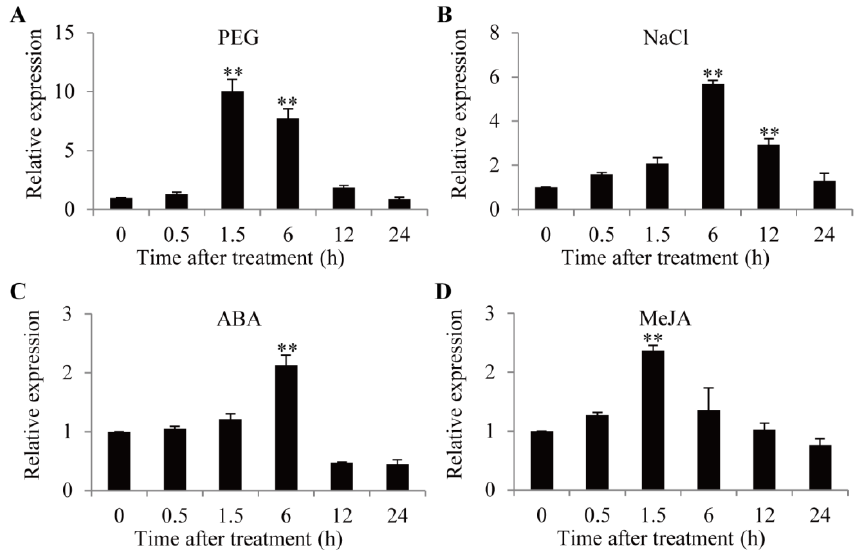
Figure 2. Expression patterns of GmTIP1;6 under drought, salt, ABA, and MeJA stress treatments in vegetable soybean seedlings. Vegetable soybean seedlings were treated with 20% PEG6000 ( A ), 250 mM NaCl ( B ), 100 µM ABA ( C ), and 100 µM MeJA ( D ). ** indicated significant differences in